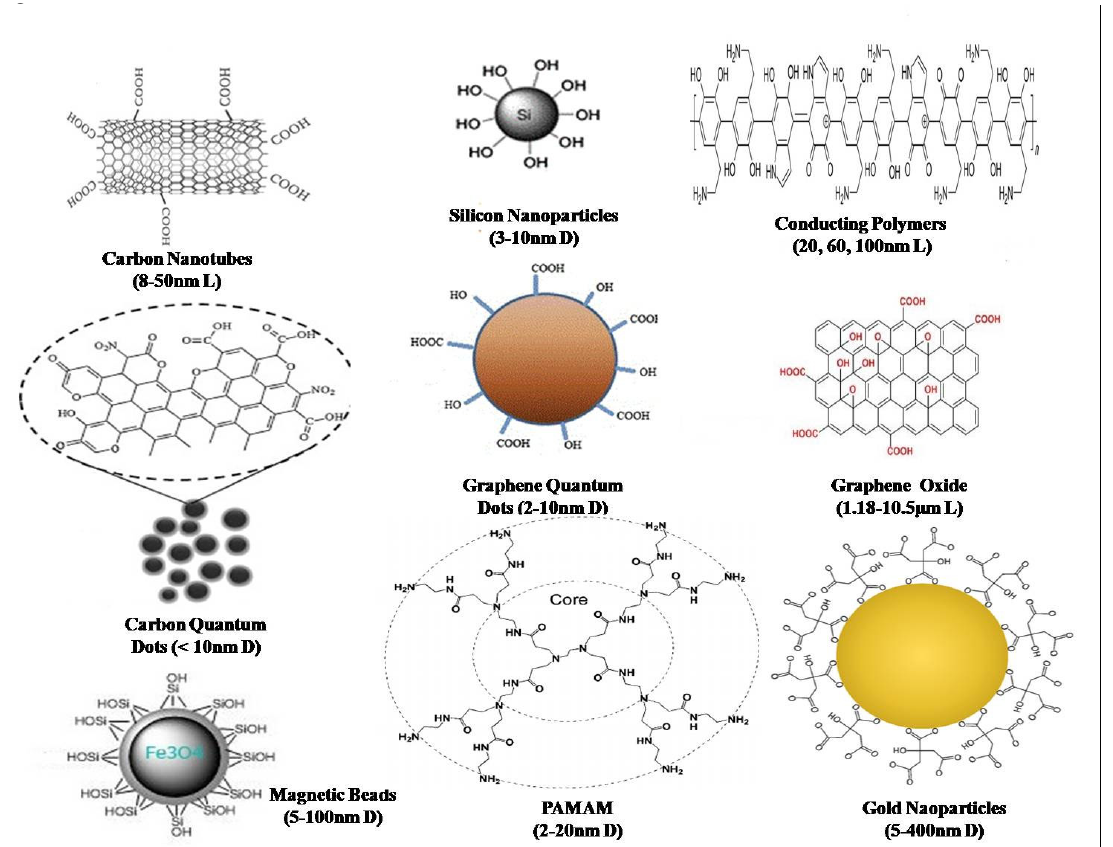
Figure 1. Commonly used nanomaterials in various kind of sensors fabrication with their sizes. L: length; D: Diameter.